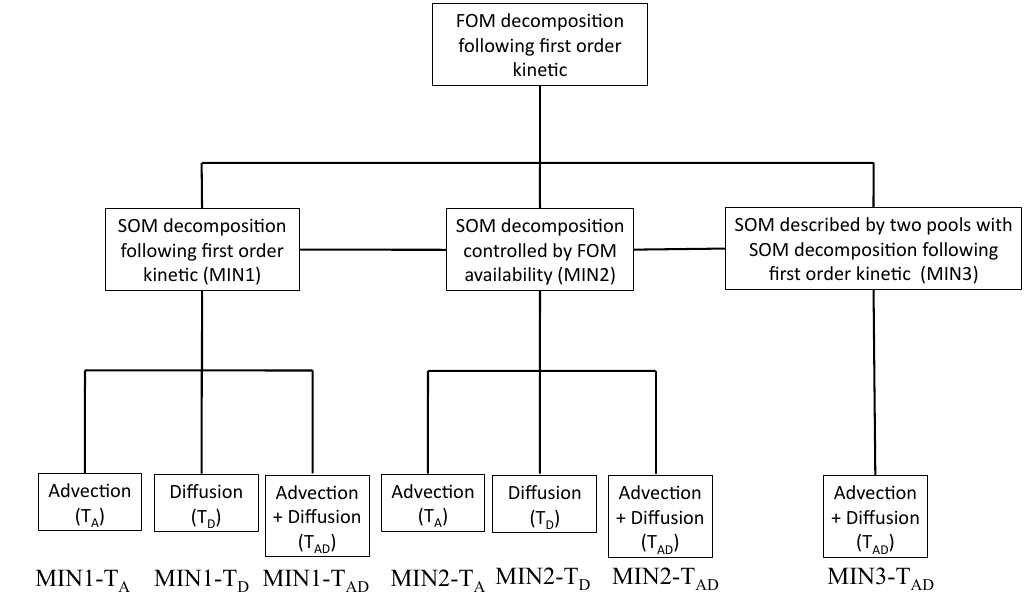
Fig. 2. Presentation of the seven formulations used in this